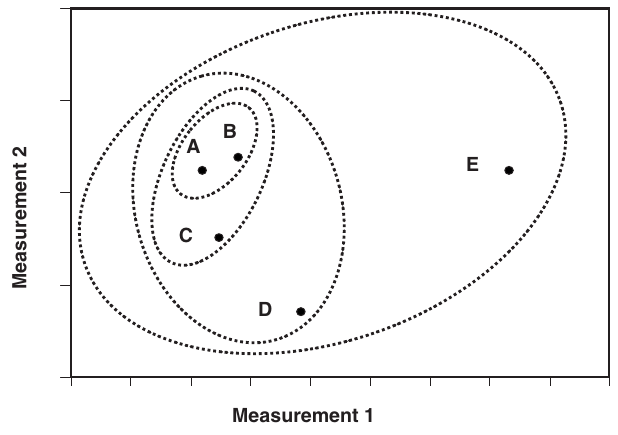
FIG. 10. An illustration of the